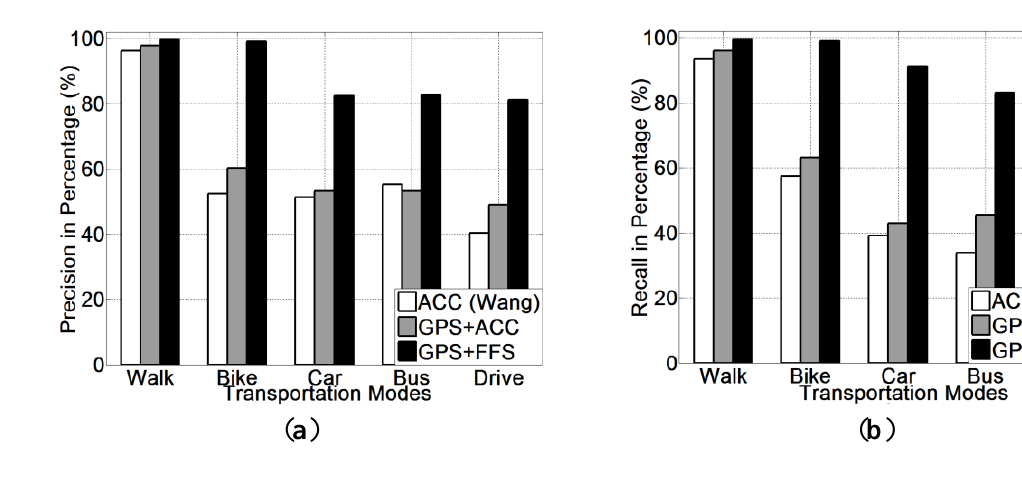
Figure 11. Transportation mode recognition results using naive Bayes: ( a ) precision; ( b )